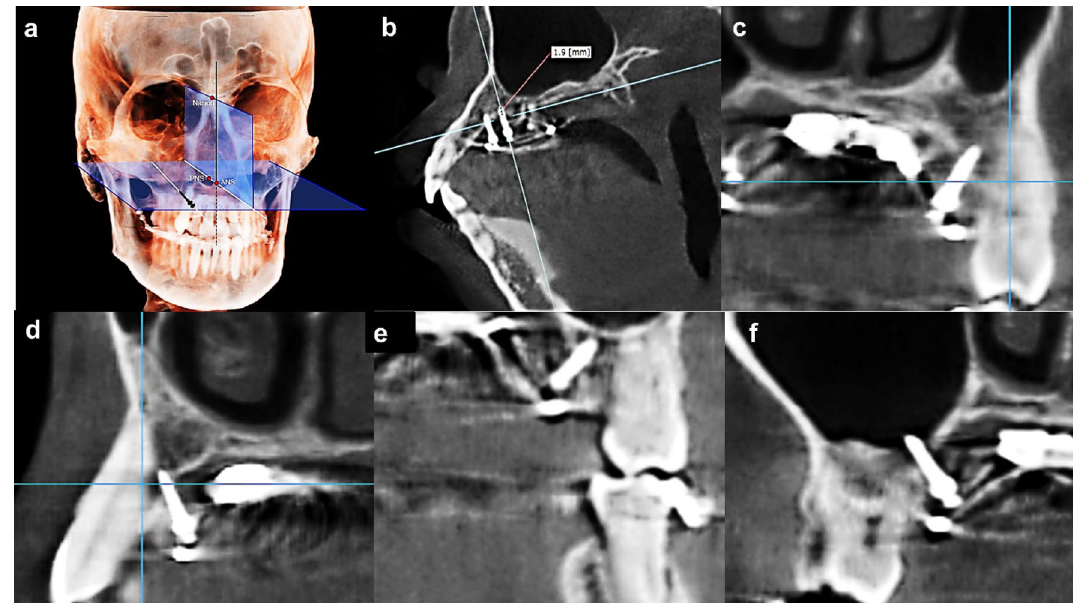
Figure 4. Miniscrew position on each plane. ( a ) Placement angle (PA) was measured using On3D. The plane through nasion (N), anterior nasal spine (ANS) and posterior nasal spine (PNS) was defined as the midsagittal plane, and PA was measured between the midsagittal plane and the straight line through the screw head and tip. ( b ) CBCT of adjusted sagittal view: placement depth (PD) of miniscrew around first premolar at right side, ( c ) CBCT image of frontal view: the surface of the miniscrew had no contact with left second premolar, ( d ) CBCT image of sagittal view: the tip of the miniscrew had contact with right canine, ( e ) CBCT image of frontal view: the tip of the miniscrew didn’t perforate left maxillary sinus, ( f ) CBCT image of frontal view: the tip of the miniscrew perforated right maxillary